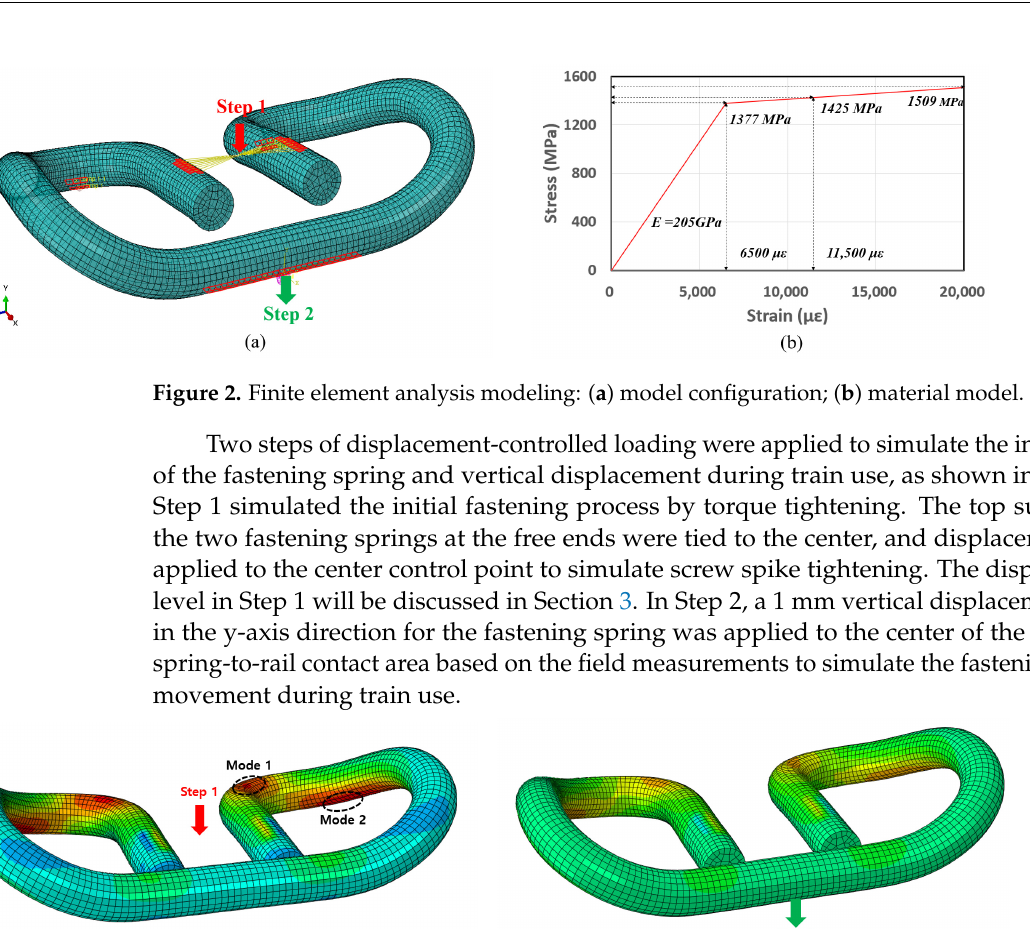
Figure 3. Maximum principal stress contours: ( a ) initial fastening (Step 1); ( b ) vertical displacement (Step 2). Figure 4. Failure modes of KR-type fastening spring from fatigue testing.